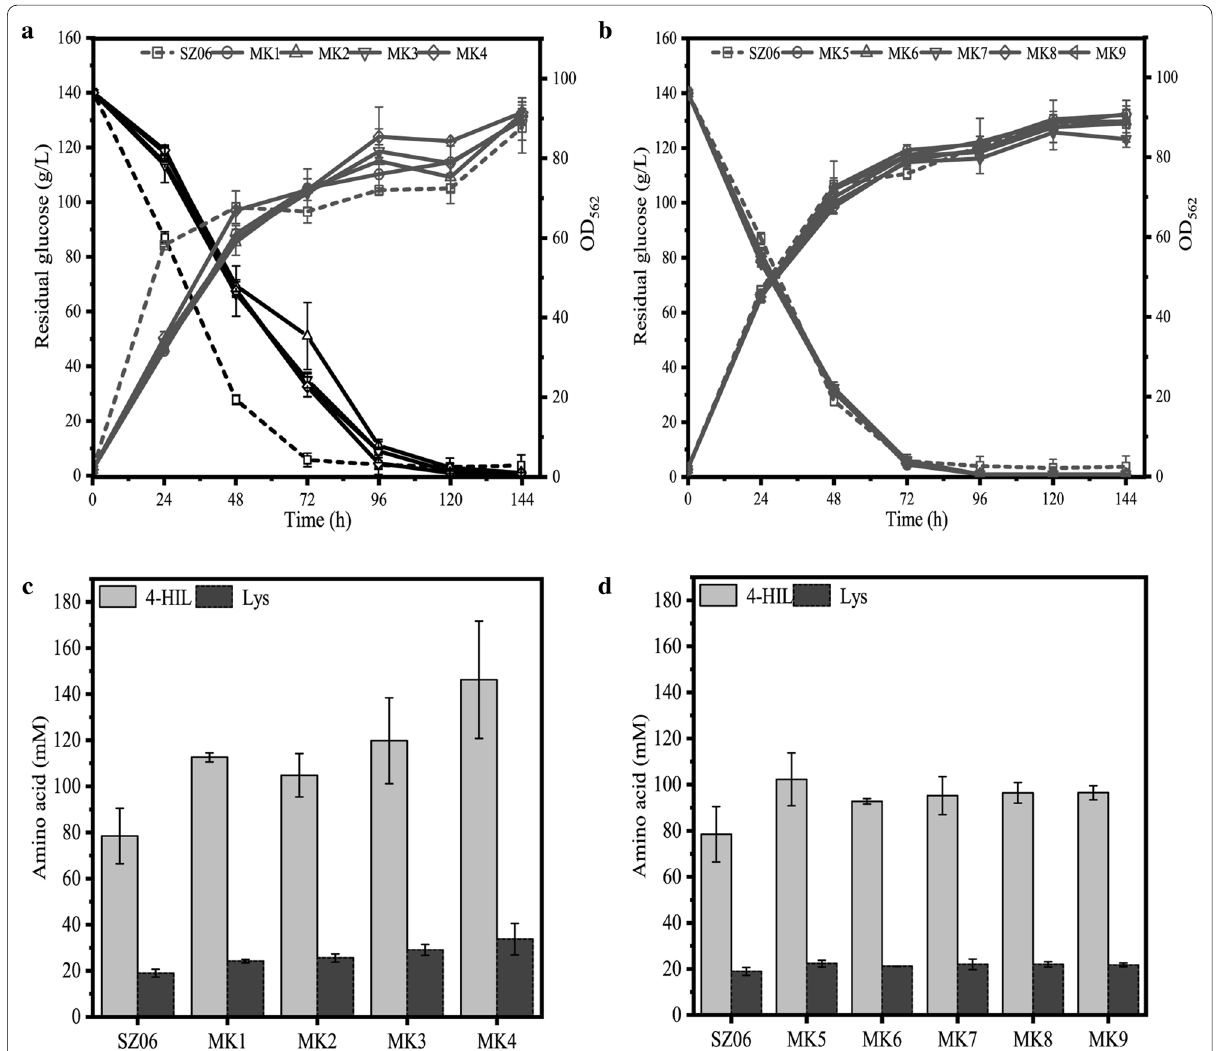
Fig. 4 The 4-HIL fermentation of mutant strains MK1 consumption of MK1 MK4, b Cell growth and glucose consumption of MK5 − concentration of MK5 −